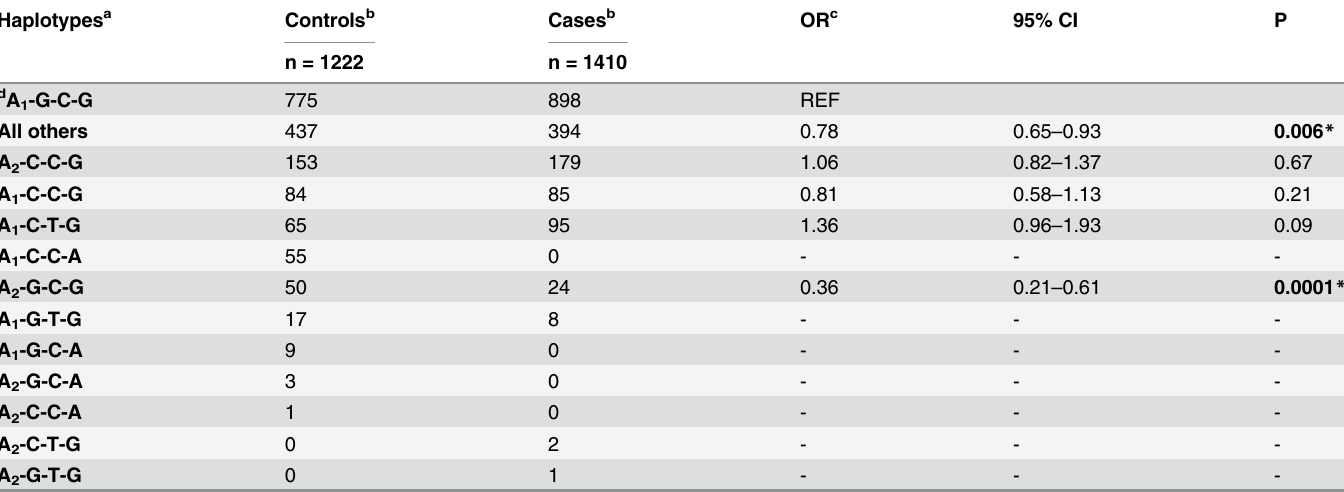
Table 2. TP53 haplotype distribution between BC patients and